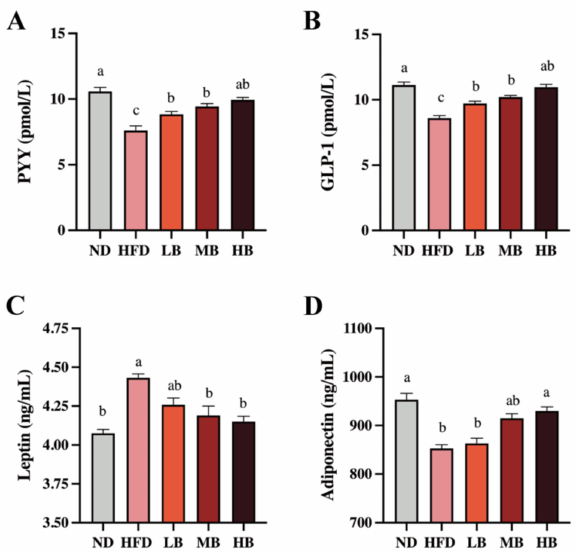
Figure 3. Effects of tartary buckwheat on the circulating gut hormone in HFD-fed mice. ( A ) Serum PYY levels. ( B ) Serum GLP-1 levels. ( C ) Serum leptin levels. ( D ) Serum adiponectin levels. Data are expressed as the mean ± SEM ( n = 8). The mean value with different letters indicates significant differences ( p <